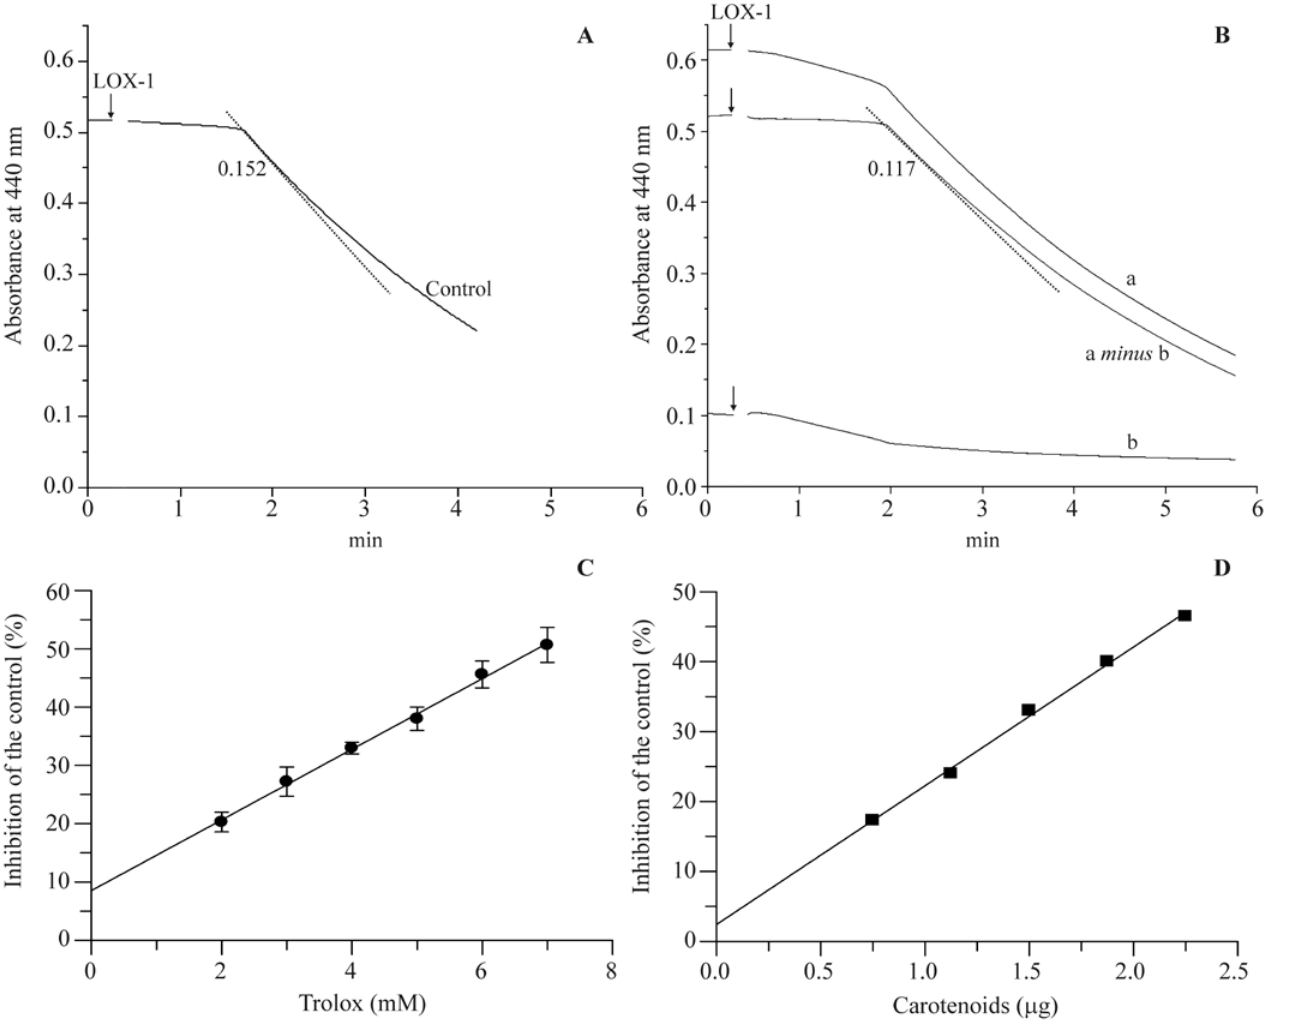
Fig. 3 - The LOX-1-dependent RNO bleaching in the absence (A, control) and presence (B) of carotenoid-enriched extract from peach fruit and linear dependence of the inhibition on Trolox concentration (C) and extract amount (D). The LOX/RNO reaction was monitored as de- scribed in Methods in the absence (A, control) and in the presence of 1.13 µg carotenoids extracted from the yellow-fleshed cv. Armking (B, trace a). In (B) the LOX-1-dependent bleaching of the same amount (1.13 µg) of carotenoid extract was also reported (trace b), as well as the curve obtained from the difference between traces a and b (trace “a minus b”). In (C) the calibration curve obtained with Trolox is reported; in (D) the (%) inhibition of the rate of the LOX/RNO reaction is reported as a function of extract amount, expressed as carotenoid content. The rates of the RNO bleaching, calculated as the highest slopes (dotted lines) to the experimental curves, are reported, expressed as ΔA · min -1 . For AA calculation see the 440 nm